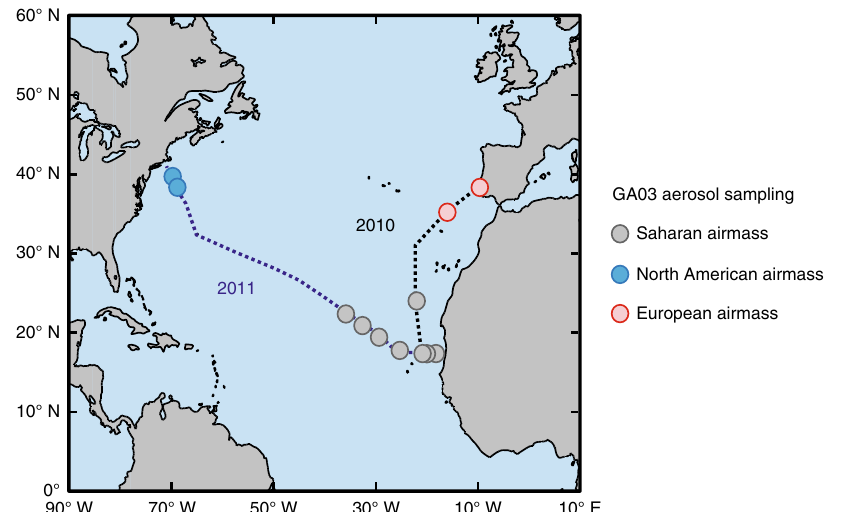
Fig. 1 North Atlantic GA03 aerosol Fe isotope sampling locations. Aerosol samples are a subset of those collected on the cruise, and are characterized as Saharan (gray), North American (blue), or European (red), according to HYPSLIT air mass back-trajectory analysis 43 . 2010 and 2011 legs of the GA03 cruises (USGT10 and USGT11) are shown separately